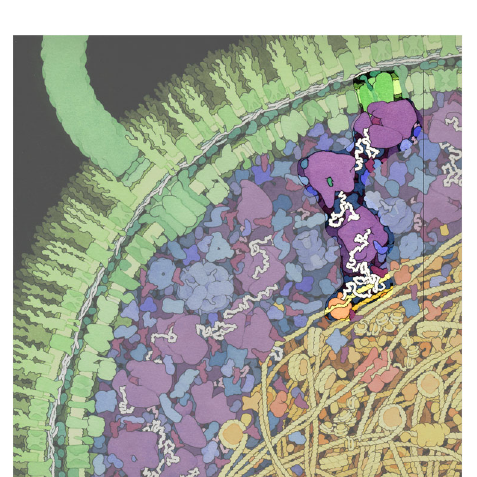
Fig. 2| Cross-sectionofasmallportionofan Escherichiacoli cell. Theouterand inner membranes studded with transmembrane proteins are shown in green. The cytoplasmic area is colored blue and purple. Enzymes are shown in blue. The nucleoid region is shown in yellow and orange. An active RNA polymerase and a nascent mRNA (white strand), loaded with ribosomes (purple) and ending at a Sec translocon (green) in the inner membrane, are highlighted as an example of transertion. Original illustration by David S. Goodsell, The Scripps Research Insti- tute (https://doi.org/10.2210/rcsb_pdb/goodsell-gallery-001; https://pdb101.rcsb. org/sci-art/goodsell-gallery/escherichia-coli) 33 .